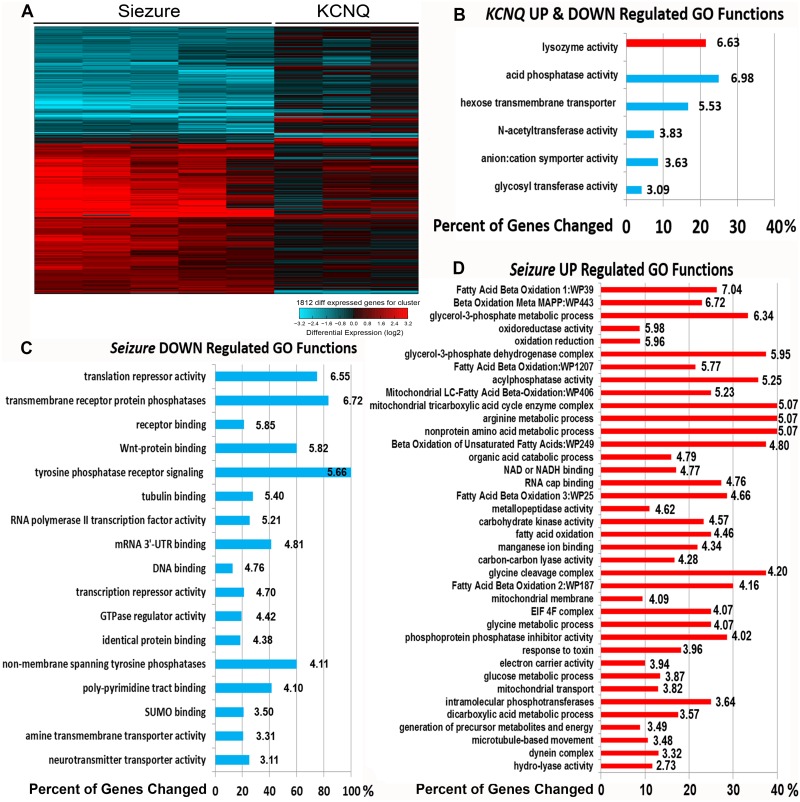
Altered gene expression and GO Functions in Sei and KCNQ mutant hearts.(A) Isolated hearts from control and channel mutant flies were subjected to gene expression analysis. Heat map shows hierarchical clustering of 1812 probesets that were significantly up (red) or down (blue) regulated in sei mutant hearts compared to WtCS (Fold>2.0, P<0.05, each line shows results for a single probeset and each column is a replicate) and the corresponding effect in hearts from KCNQ mutants (compared to WtPE). (B) Significantly UP (red) and DOWN (blue) regulated Go Functions (Z score>2) identified in KCNQ370 mutant hearts are shown with the corresponding percent of category genes that were significantly altered. Z scores are shown at the end of all bars. (C) Significantly Down regulated Go Functions identified in sei mutant hearts. (D) Significantly UP regulated Go Functions (Z score>2) in sei mutant hearts are shown.